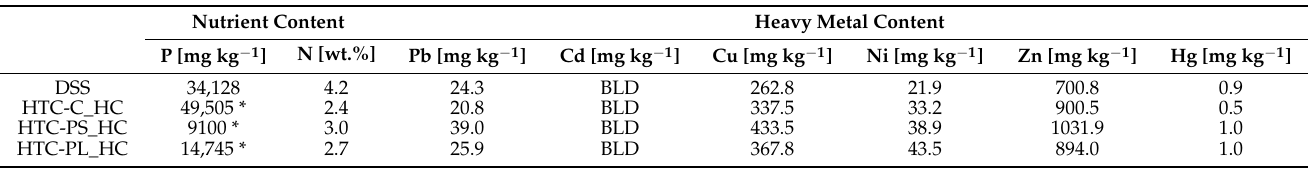
Table 2. Content analysis of raw material and hydrochars (HC). (C = Control; PS = P stripping; PL = P leaching; BLD = bellow limit of detection) ( n = 2).